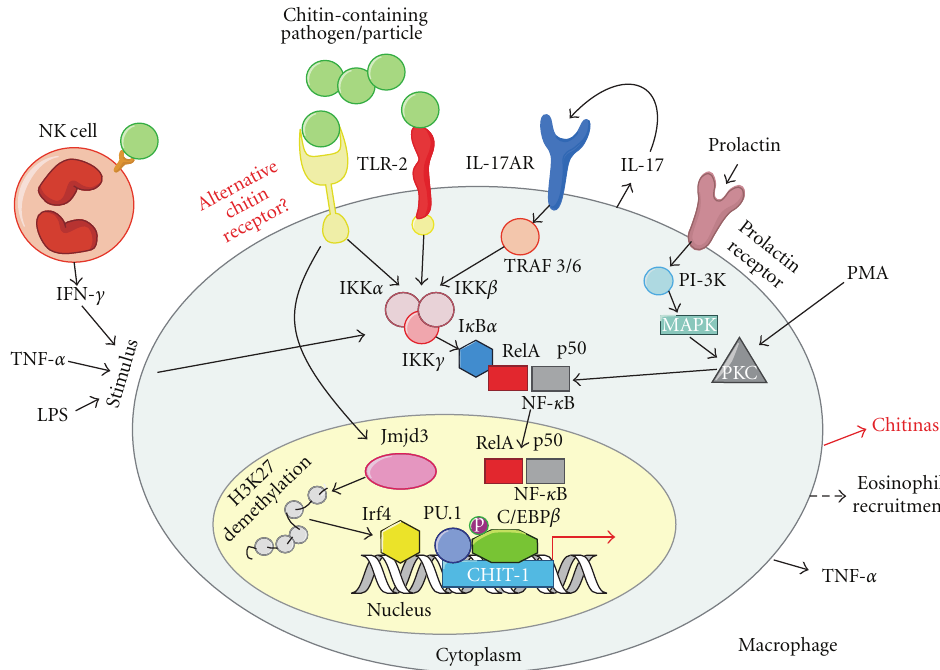
Figure 3: Hypothetical model for a molecular chitinase response to chitin-containing pathogens or particles. Chitin recognition leads to the expression of chitinase, TNF- α , IL-17, and eosinophil recruitment [83, 84]. NF- κ B serves as the primary signaling pathway involved in the recognition of most fungal cell wall components (see Figure 2) [45]; therefore, its involvement in the expression of chitinase in response to a chitin-containing pathogen or particle is highly likely. Secretion of IFN- γ by NK cells induces macrophage priming caused by stimulation with a chitin-containing pathogen or particle [60–63]. IFN- γ , LPS, TNF- α , and PMA up-regulate chitinase activity [16–19], possibly through an NF- κ B inflammatory-mediated pathway. IL-17 secretion upon macrophage stimulation with chitin increased levels of IL-17-AR and was TLR-2 dependent [84]. Either TLR-2 or an alternative chitin-specific receptor may recognize chitin-containing pathogens or particles and mediate chitinase activity. Prolactin stimulation of macrophages leads to chitinase expression via a PI-3K, MAPK, and NF- κ B pathway [16–19]. Activation of Jmjd3, leads to demethylation of H3K27 and recruitment of the transcription factor Irf4, which is associated with M2 macrophage polarization in response to chitin stimulation [59]. Expression of the chitinase encoded by the CHIT-1 gene is regulated via PU.1 and C/EBP β . The latter is phosphorylated (p) to induce CHIT-1 expression [85]. NF- κ B, nuclear factor kappa-light- chain-enhancer of activated B cells; IFN- γ : interferon gamma; NK cells: natural killer cells; LPS: lipopolysaccharide; TNF- α : tumor necrosis factor alpha; PMA: phorbol 12-myristate 13-acetate; IL-17: interleukin-17; IL-17-AR: interleukin-17A receptor; TLR-2: toll-like receptor-2; PI-3K: phosphatidylinositol 3-kinase; MAPK: Mitogen-activated protein kinase; Jmjd3: Jumonji domain containing-3; H3K27: histone 3 Lys27 demethylase; CHIT-1: chitotriosidase; C/EBP β : CCAAT-enhancer-binding protein